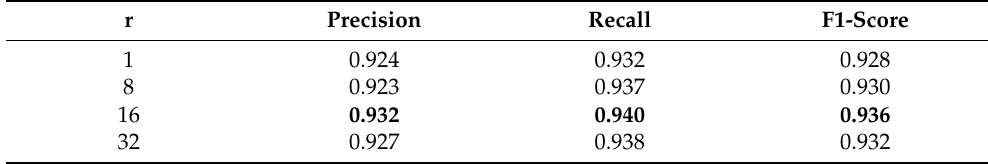
Table 1. Influence of reduction rate on